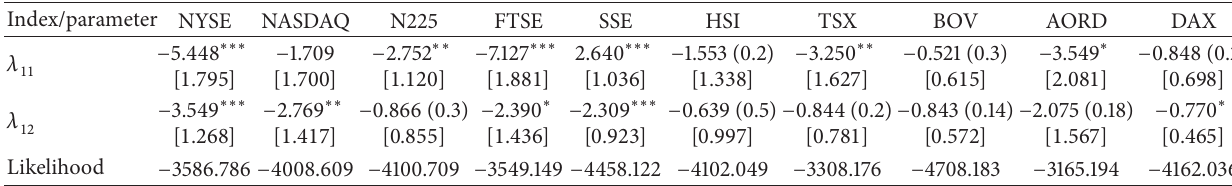
Table 11: Results of TVRAS-GARCH-M model ( 𝑃 10 𝑡 ).